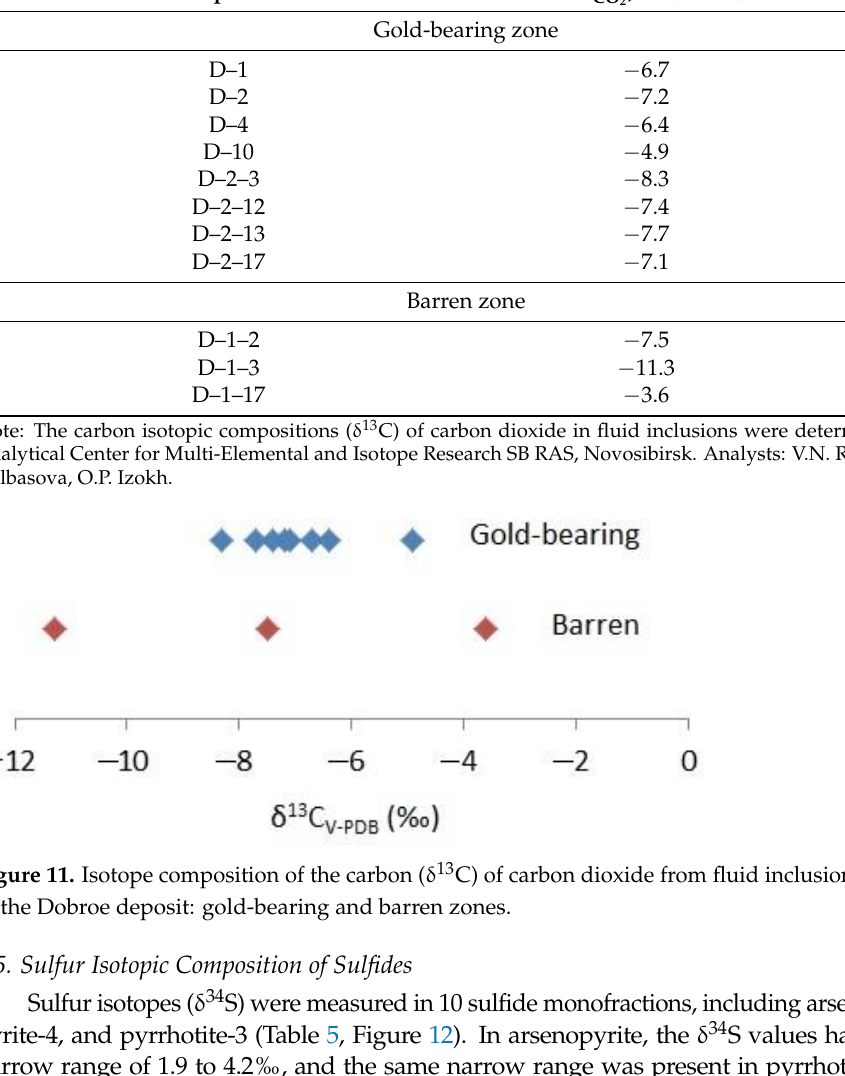
Table 4. Carbon isotope composition (δ 13 C) of carbon dioxide in fluid inclusions in quartz from the Dobroe gold deposit. Sample No.